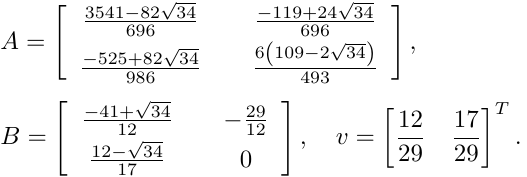
Figure 3 as functions of c 2 , which varies in the interval of admissible